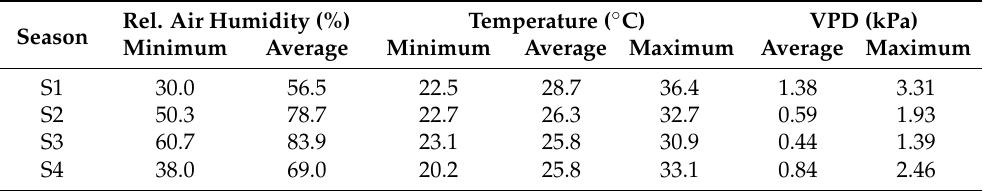
Table 1. Climatic data of the region during the assessments. Average of daily mean